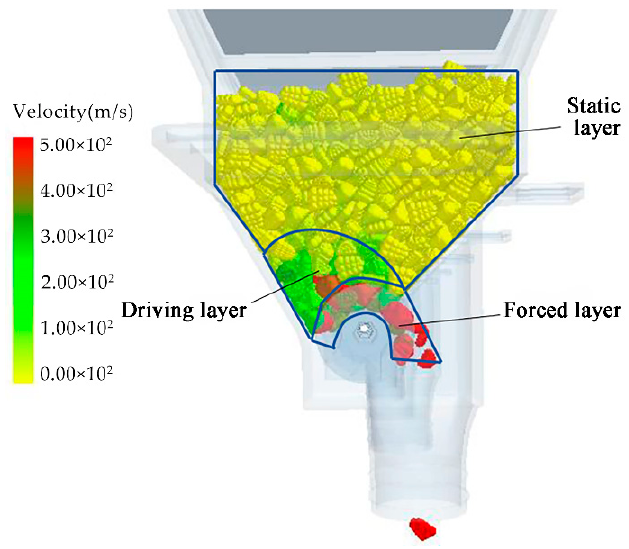
Figure 15. Schematic diagram of seed movement in the device.